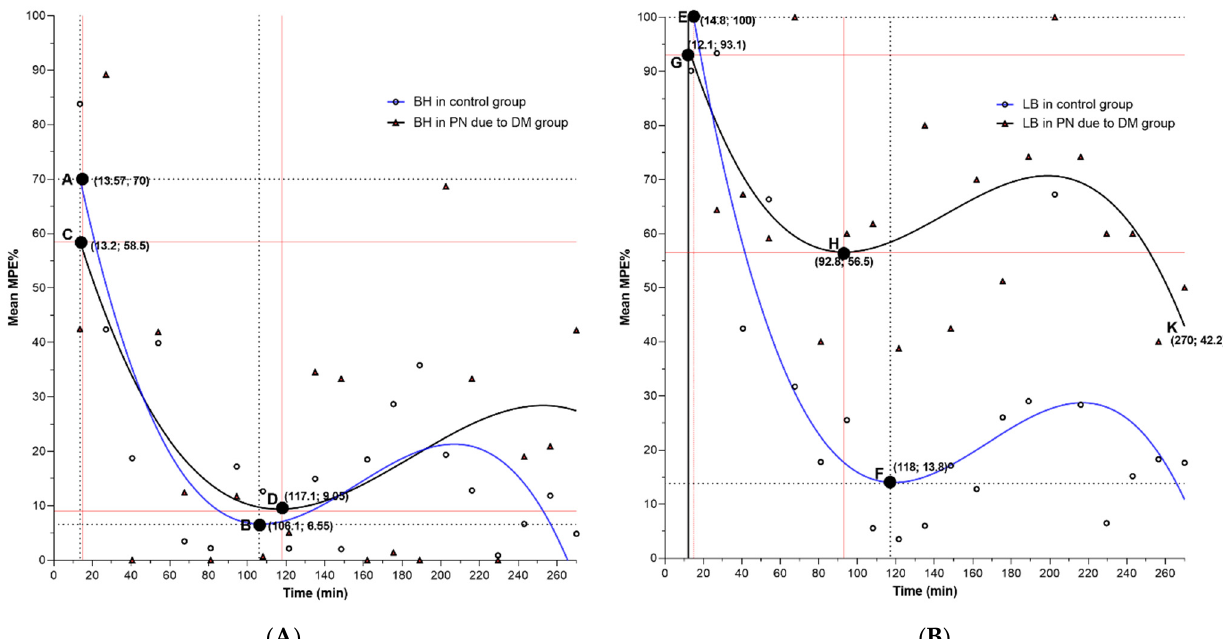
Figure 1. Relationship between mean % MPE and time sequence (13.5 min) for the control group and mice with peripheral neuropathy due to DM treated with bupivacaine hydrochloride (BH) ( A ) and liposomal bupivacaine (LB) ( B ): The curves are drawn with interpolation using 3rd order polynomial functional model. The initial MPE % is marked with capital letters A, C, E, G, and the block release with letters B, D, F, H, and K. The raw data, including means and variability, is presented in the Supplementary Material (Supplementary Table S1). DM—diabetes mellitus, PN—peripheral neuropathy MPE—maximal possible effect.